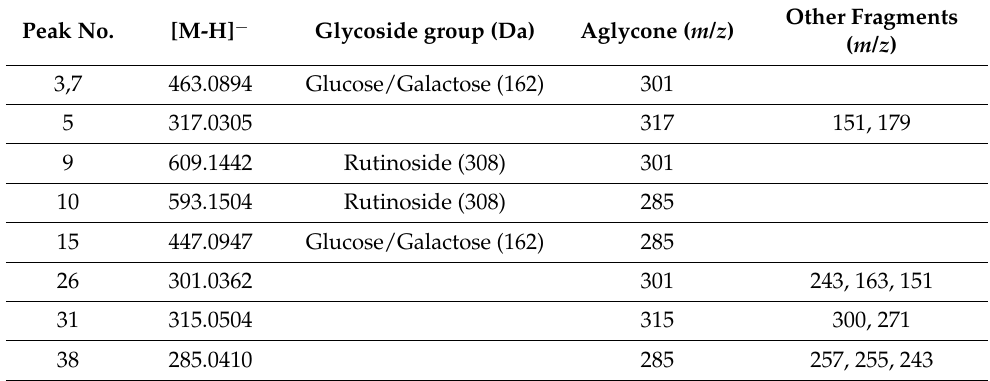
Table 3. UPLC-ESI-MS characterization of flavonoids in Physalis peruviana samples from Costa Rica. Peak No.